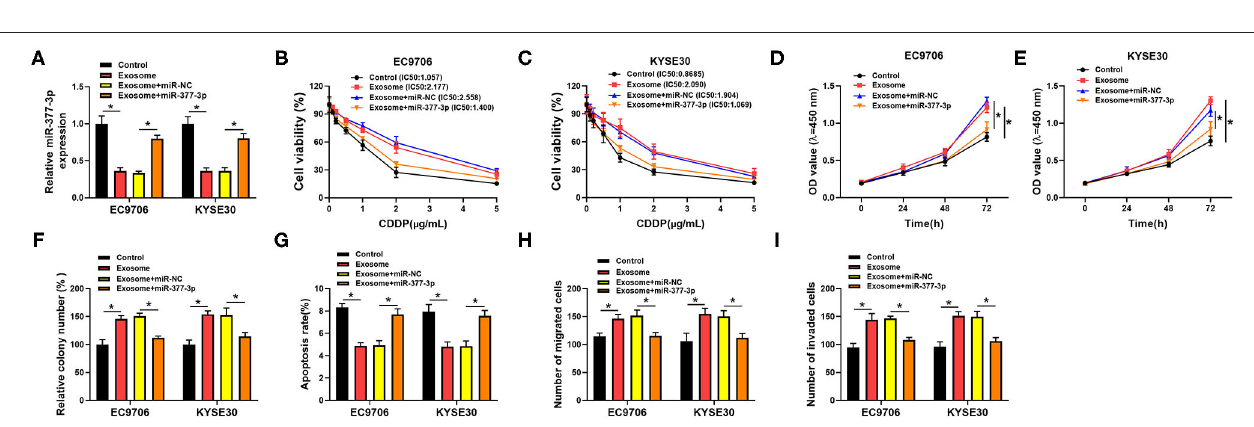
FIGURE 5 | Overexpression of miR-377-3p attenuated the exosomal circ_0000337-mediated CDDP resistance in esophageal cancer cells. EC9706 and KYSE30 cells were treated with control, exosome, exosome + miR-NC, and exosome + miR-377-3p. (A) Expression of miR-377-3p was detected in treated EC9706 and KYSE30 cells. (B,C) IC50 value of CDDP was measured by CCK-8 assay in treated EC9706 and KYSE30 cells. (D,E) Proliferation was detected in treated EC9706 and KYSE30 cells. (F) Colony number was calculated in treated EC9706 and KYSE30 cells. (G) Apoptosis rate was tested in treated EC9706 and KYSE30 cells. (H,I) Migration and invasion were examined in treated EC9706 and KYSE30 cells. * P <